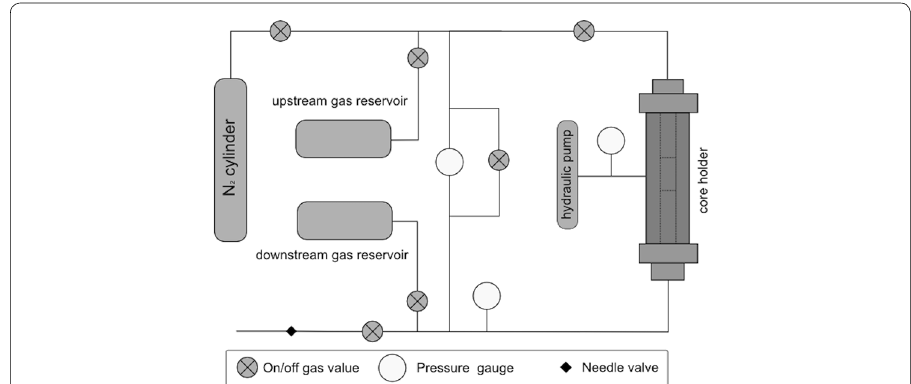
Fig. 4 Schematic diagram of the components of the pulse decay permeameter used for